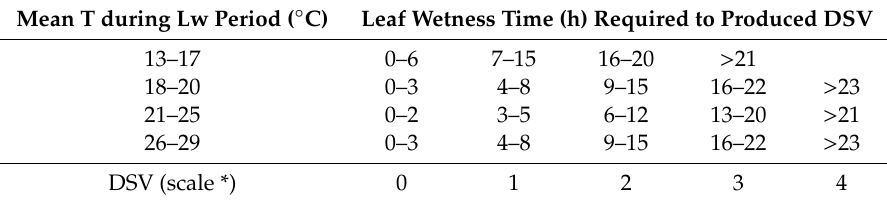
Table 2. Disease severity values of FAST model according to leaf wetness period and average ambient air temperature during the wetness period [26].